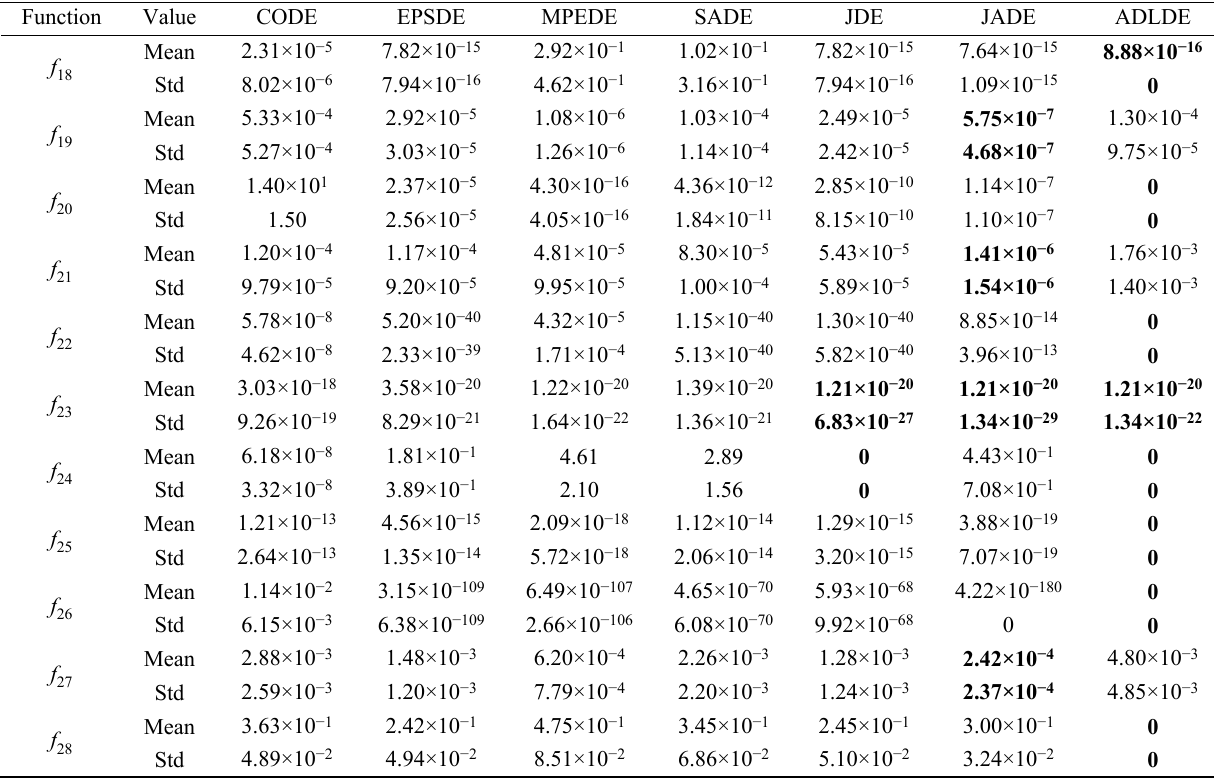
Table A4 Function error values of benchmark functions when D =